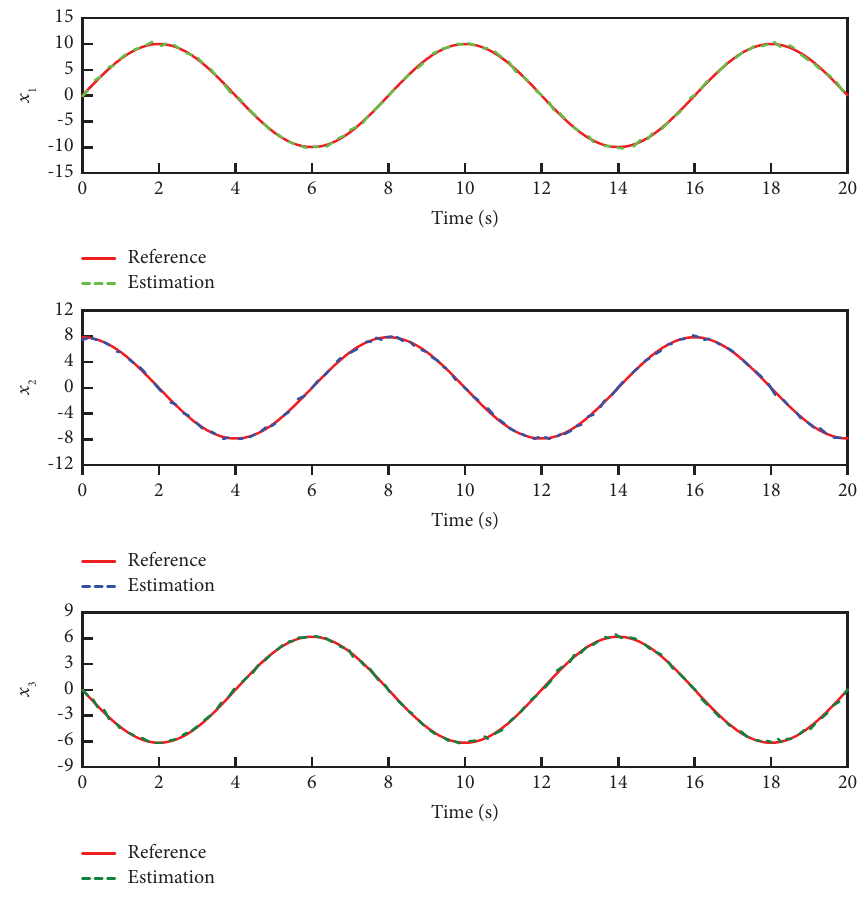
Figure 6: State variables estimation results of sinusoidal signal.